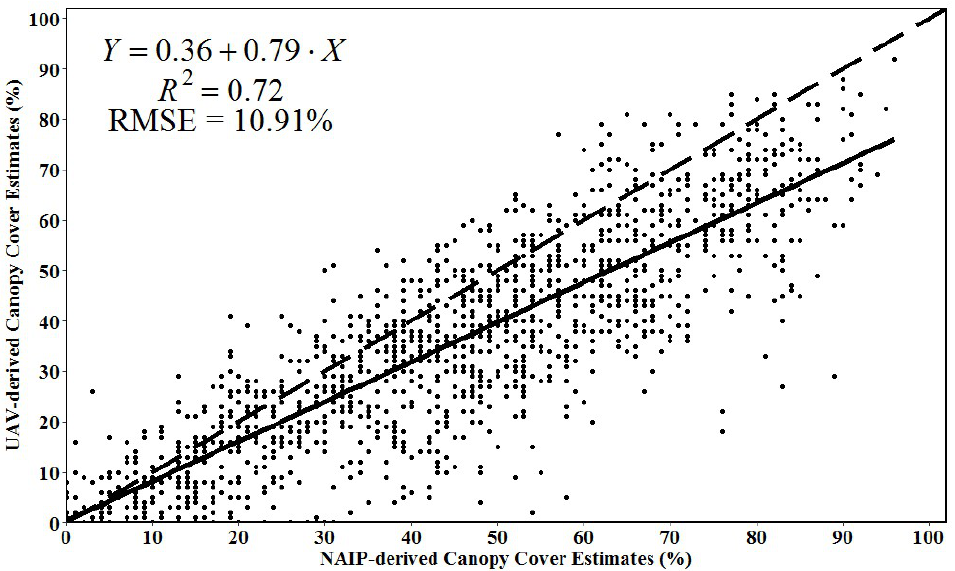
Figure 3. Regression relationship between the UAV- and NAIP-derived canopy cover estimates with 10 m resolution. The dashed line represents the 1:1 line, and the solid line is the fitted linear regression line.